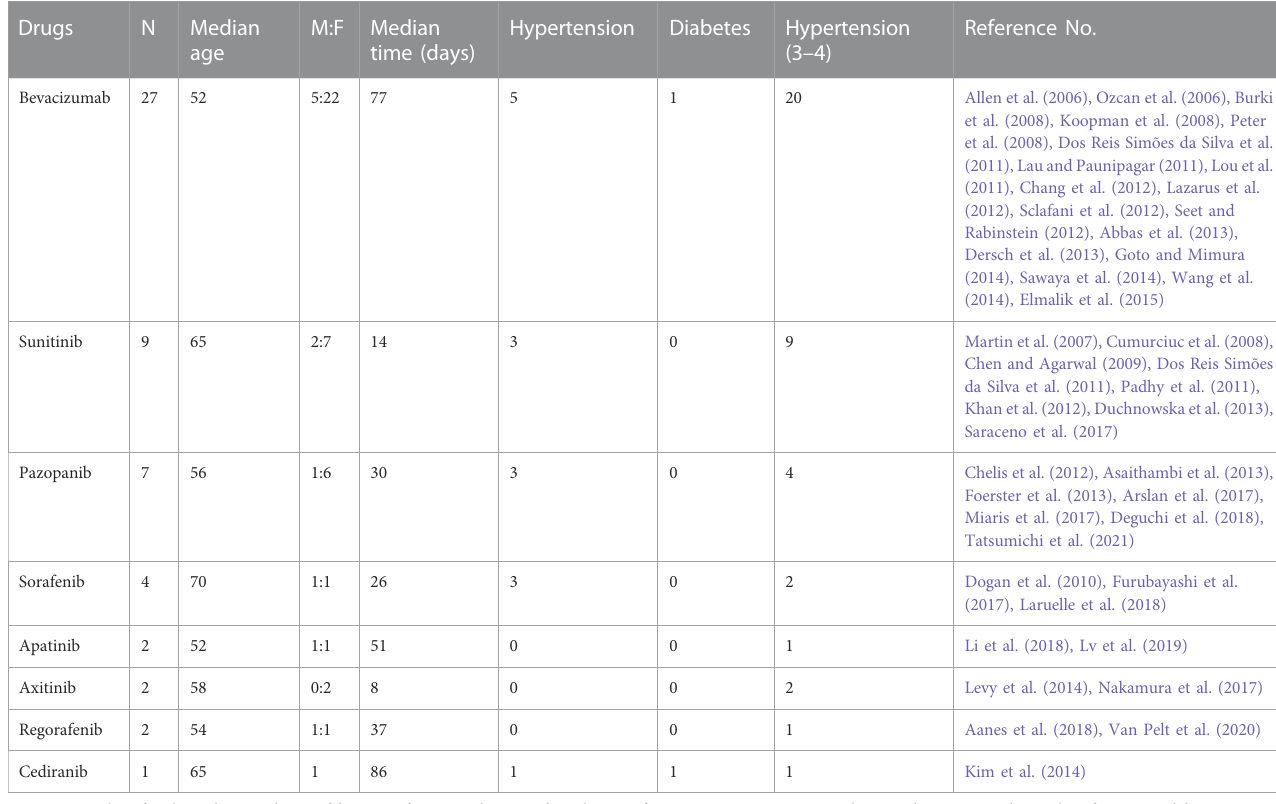
TABLE 1 Cases of PRES associated with antiangiogenic